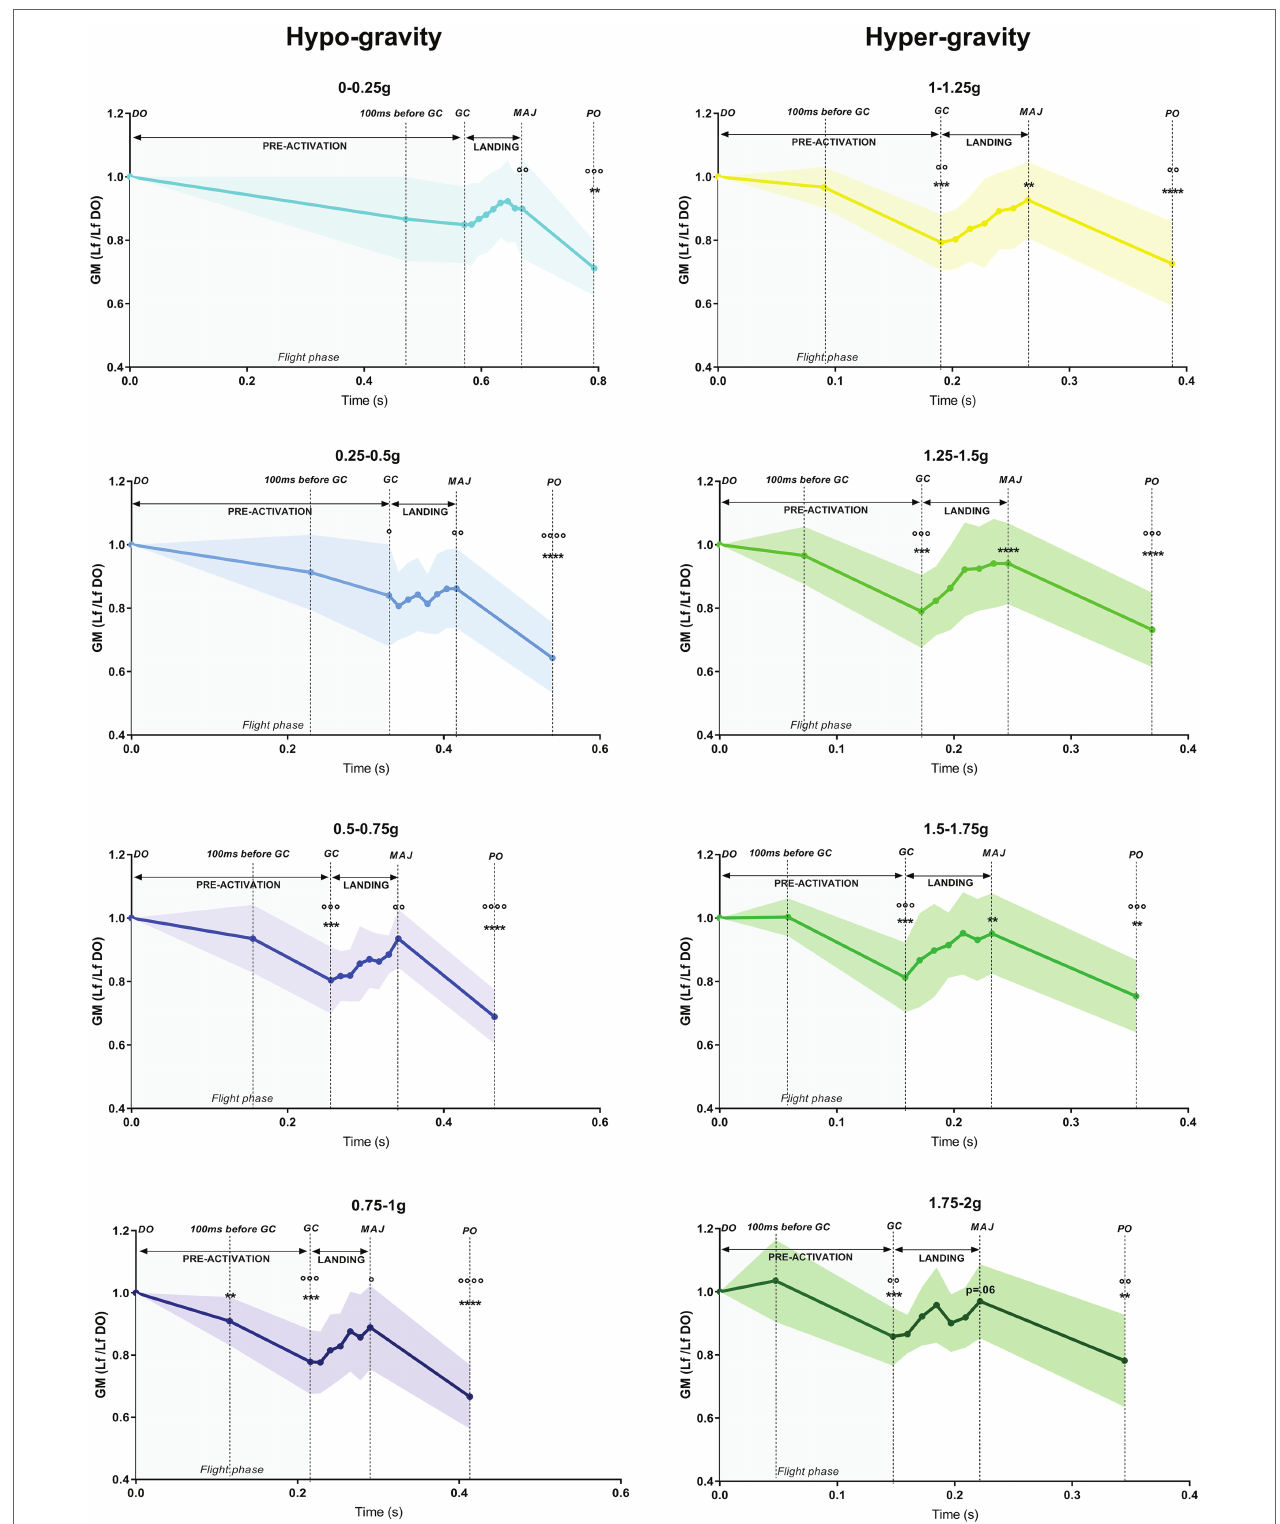
FIGURE 7 | Time course of the gastrocnemius medialis (GM) fascicle length (Lf) variations during drop jumps in hypo-gravity and hyper-gravity. Values are normalized to drop-off (DO) Lf. Results shown as mean ± SD of maximum three jumps per gravity level per subject. ** p < 0.01 vs. previous jump time point; *** p <0.001 vs. previous jump time point; ° p < 0.05 vs. DO; °° p < 0.01 vs. DO; °°° p < 0.001 vs. DO; °°°° p < 0.0001 vs.